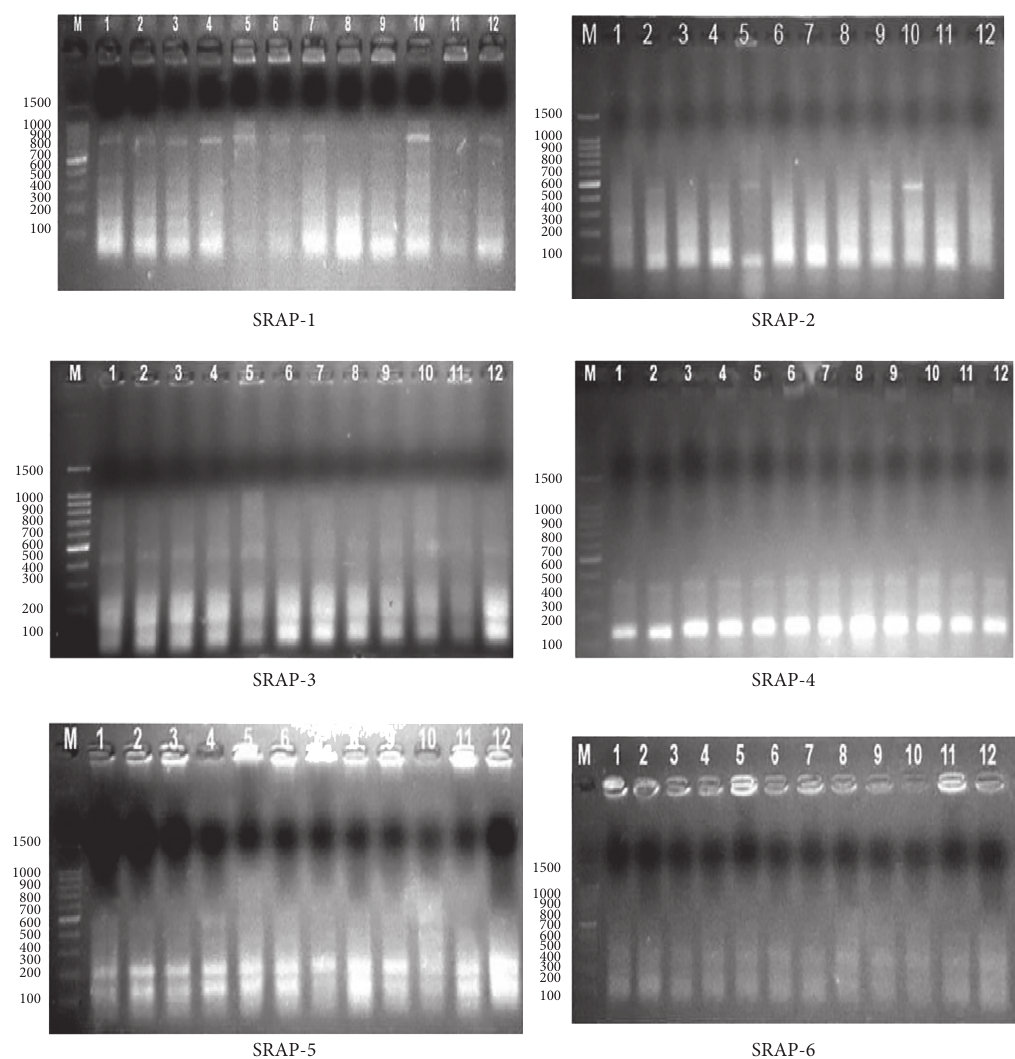
Figure 7: SRAP-PCR profiles using six primers of two wheat cultivars treated and untreated with nanoparticles at 75 days from sowing. Lane M: 100bp DNA Ladder; Gimeza 12 (lane 1: WW (control); lane 2: WW+nano-TiO 2 ; lane 3: WW +nano-ZnO; lane 4: WS; lane 5: WS +nano-TiO 2 ; and lane 6: WS +nano-ZnO); Sids 13 (lane 7: WW (control); lane 8: WW +nano-TiO 2 ; lane 9: WW +nano-ZnO; lane 10: WS; lane 11: WS +nano-TiO 2 ; and lane 12: WS+